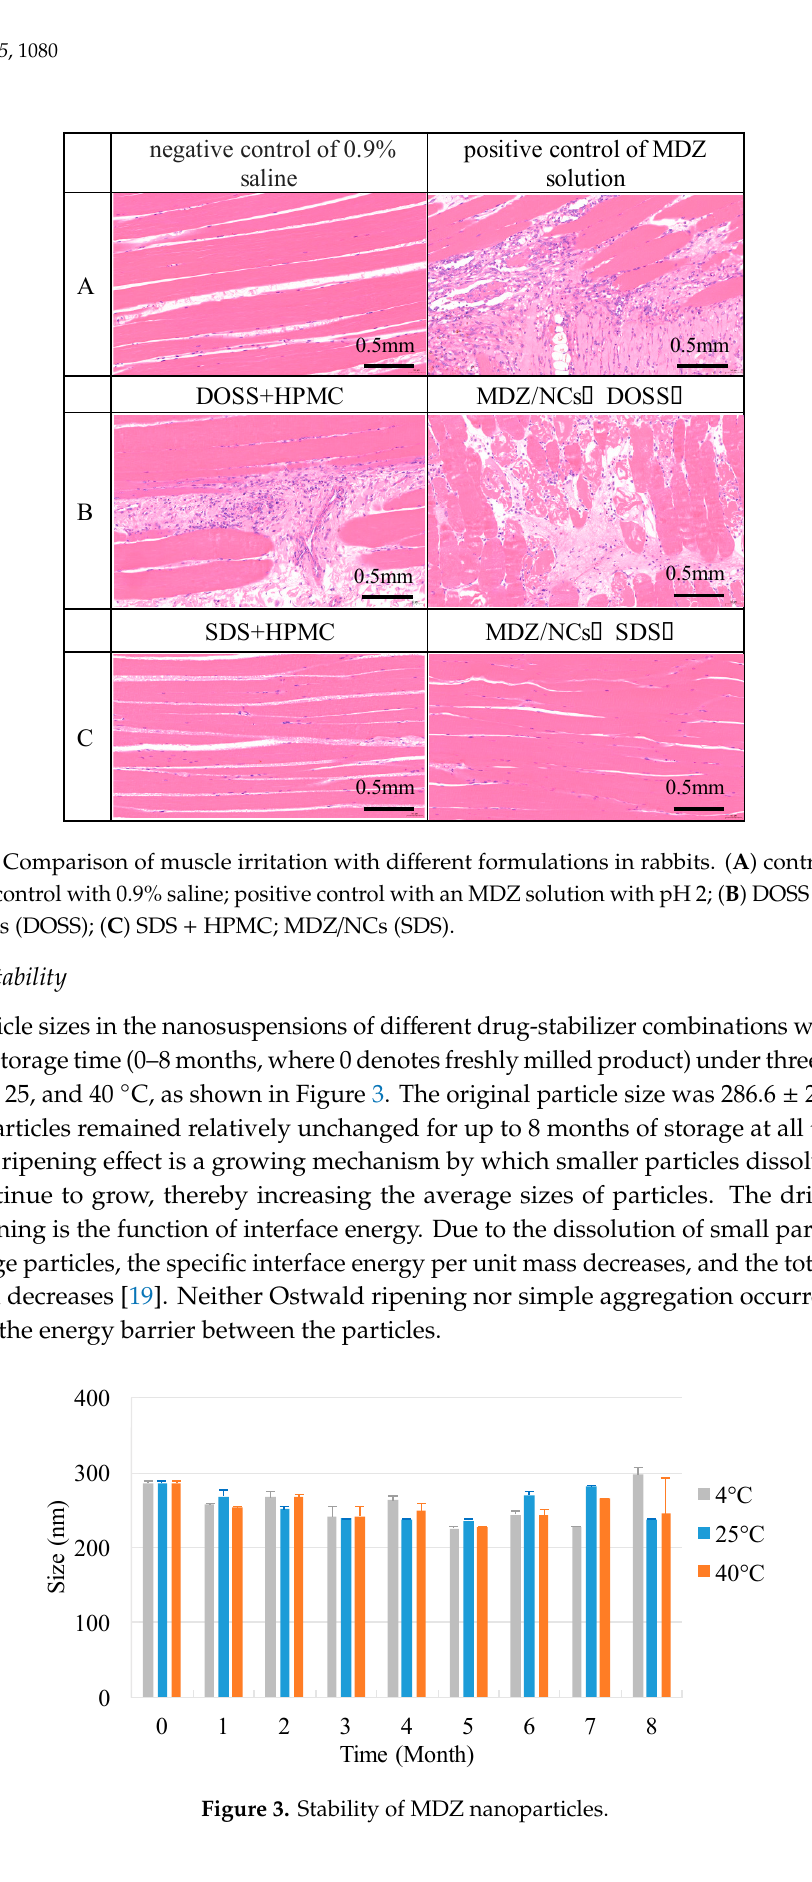
Figure 3. Stability of MDZ nanoparticles.